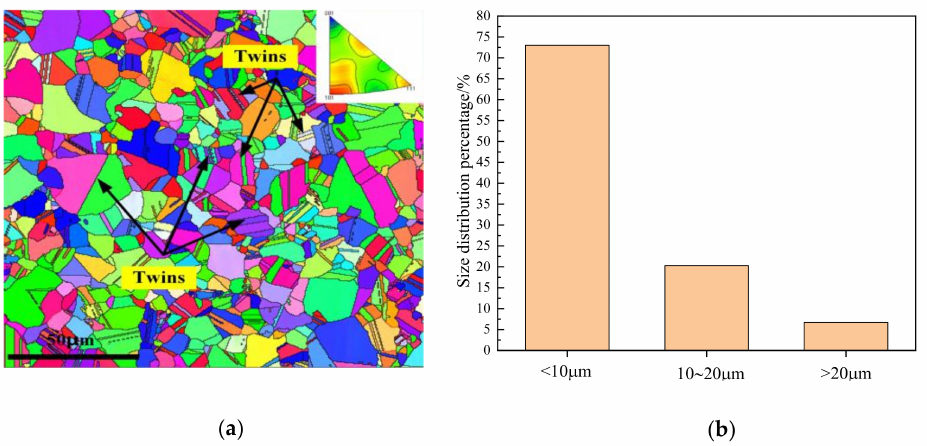
Figure 8. EBSD microstructure and grain distribution of the sintered sample: ( a ) EBSD microstructure of the sample after sintering; ( b ) grain distribution.